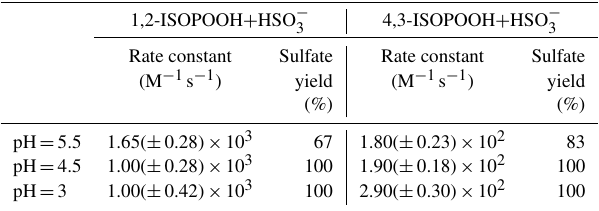
Table 1. Sulfate production rate constants and yields in the aque- ous phase due to oxidation of SO 2 , aq via 1,2-ISOPOOH and 4,3- ISOPOOH (Dovrou et al.,